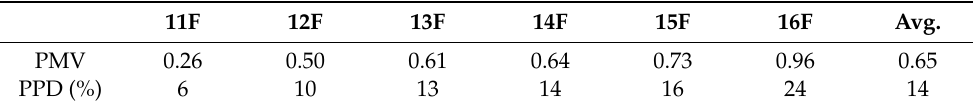
Table 7. PMV-PPD values with weather condition at 24 ◦